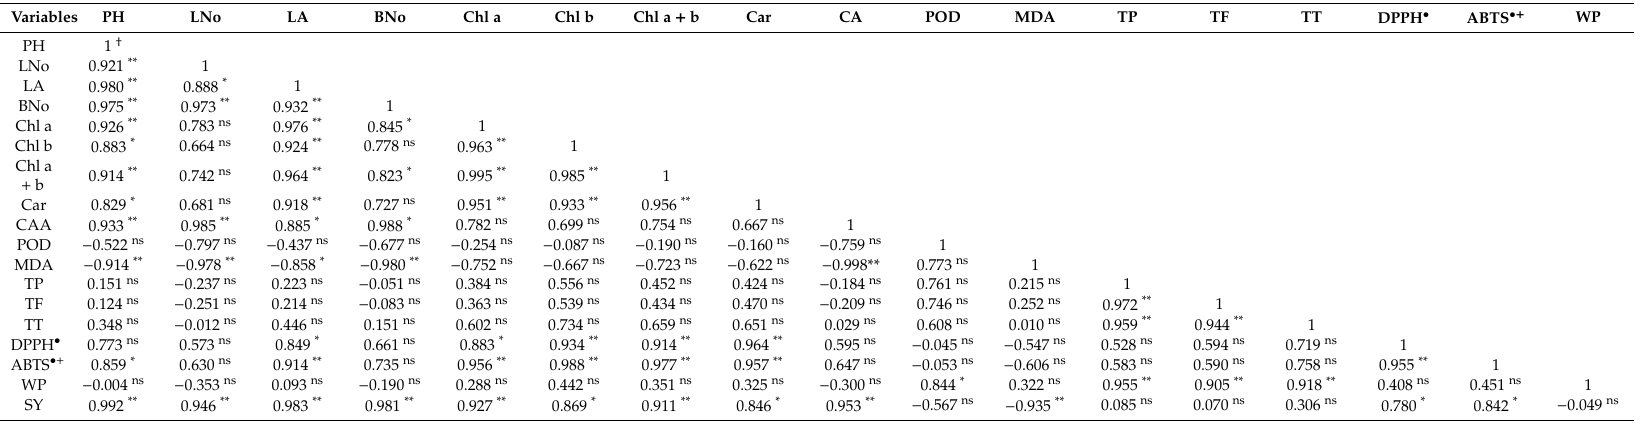
Table 8. Pearson’s correlation coe ffi cients (below diagonal) among all studied attributes of common bean plants grown under two water management and three ascorbic acid